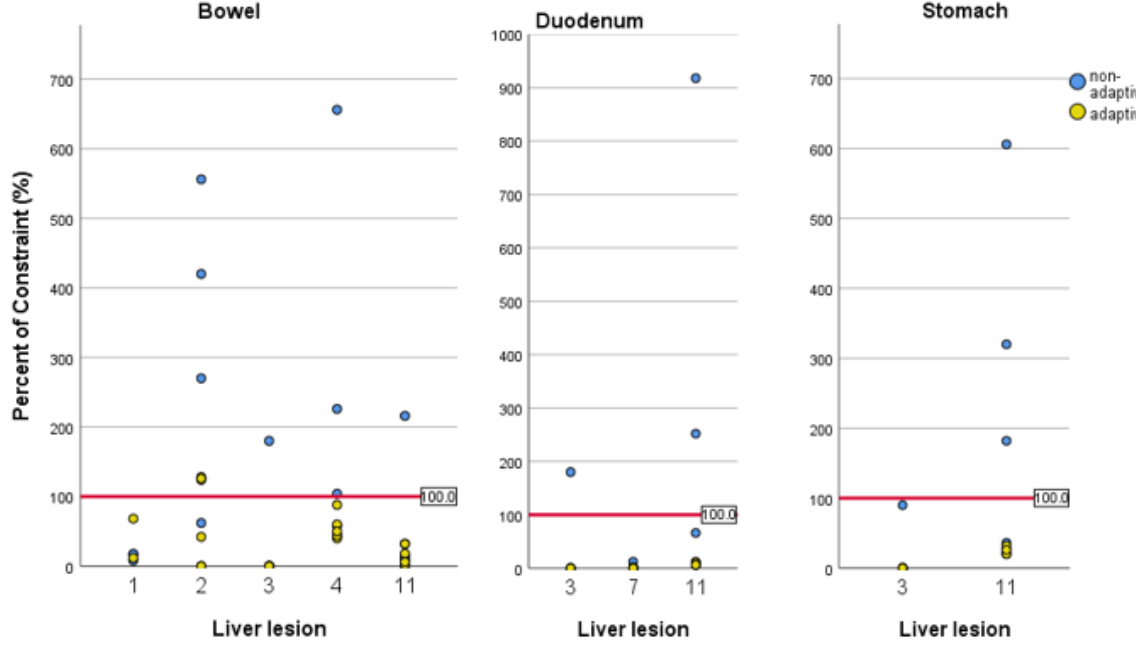
Figure 3. Compliance with OAR constraints for selected treated lesions. For the lesions not shown, there was no constraint violation either with adaptive nor with non-adaptive planning. The red horizontal line marks the prescribed constraint for each patient and OAR.